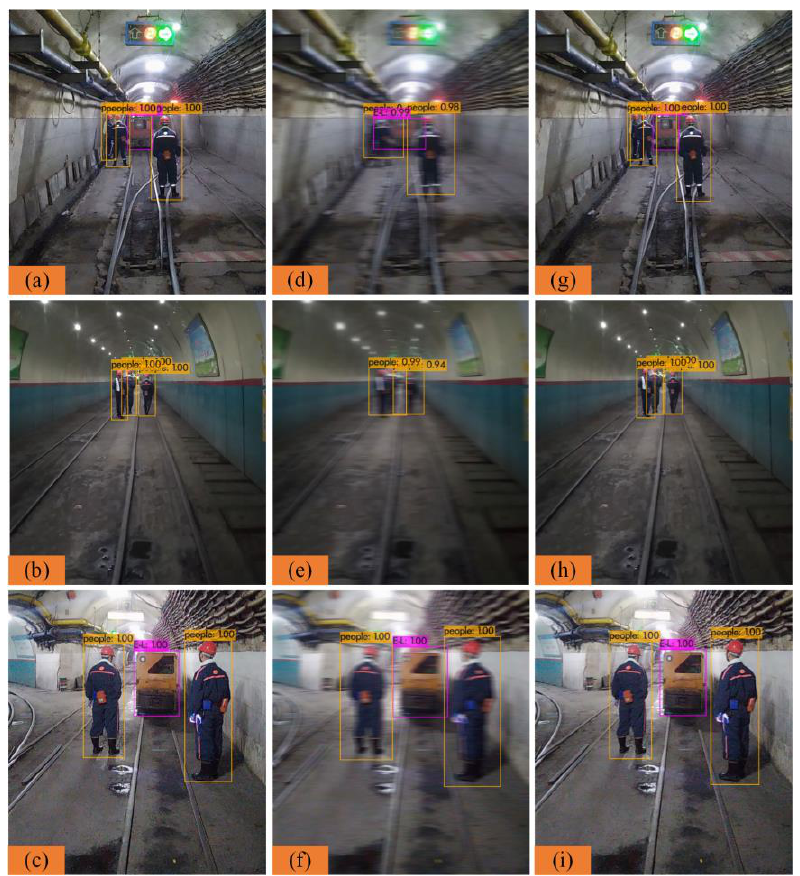
Figure 9. Detection results for some images in the three datasets. ( a – c ) Clear pictures in dataset 1; ( d – f ) blurred pictures in dataset 2; and ( g – i ) deblurred images in dataset 3.